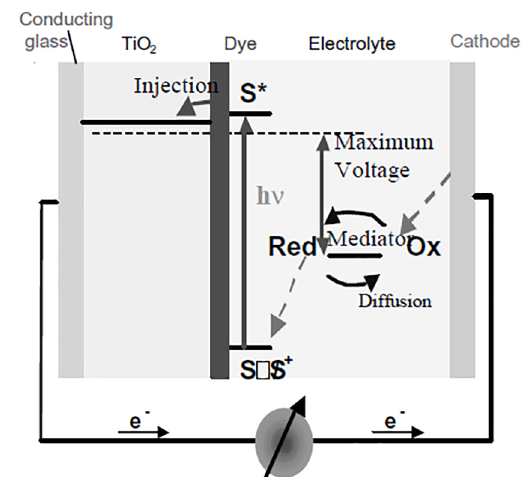
Figure 1. Working principle of a DSSC (Gratzel,